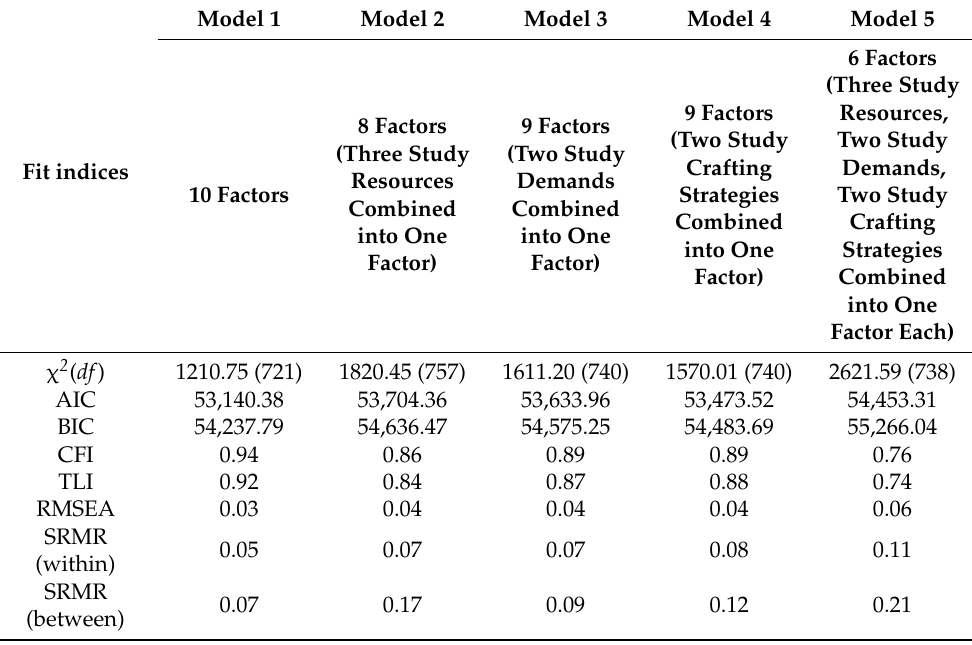
Table 2. Model fit indices for the tested